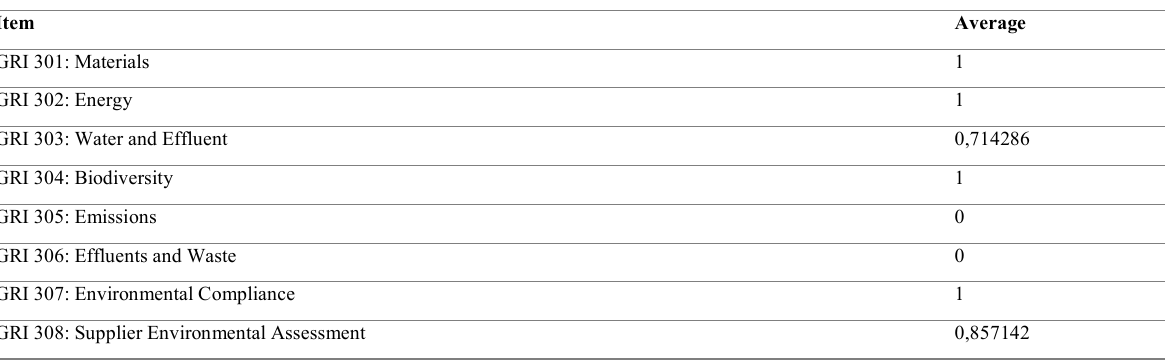
Table 4 . Environmental Item